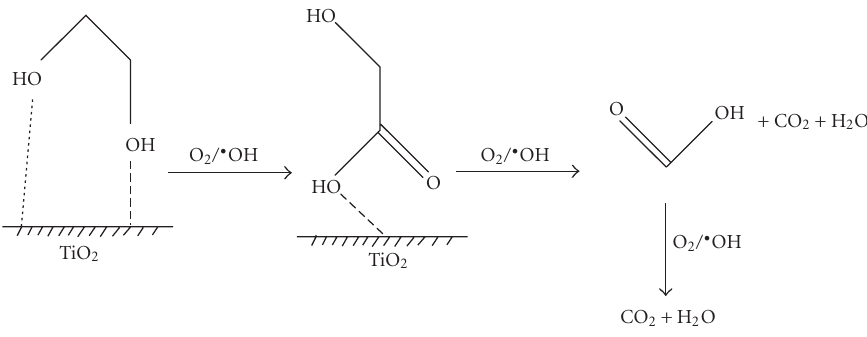
Figure 7: Outline of aqueous photocatalytic oxidation reaction of ethylene glycol on TiO 2